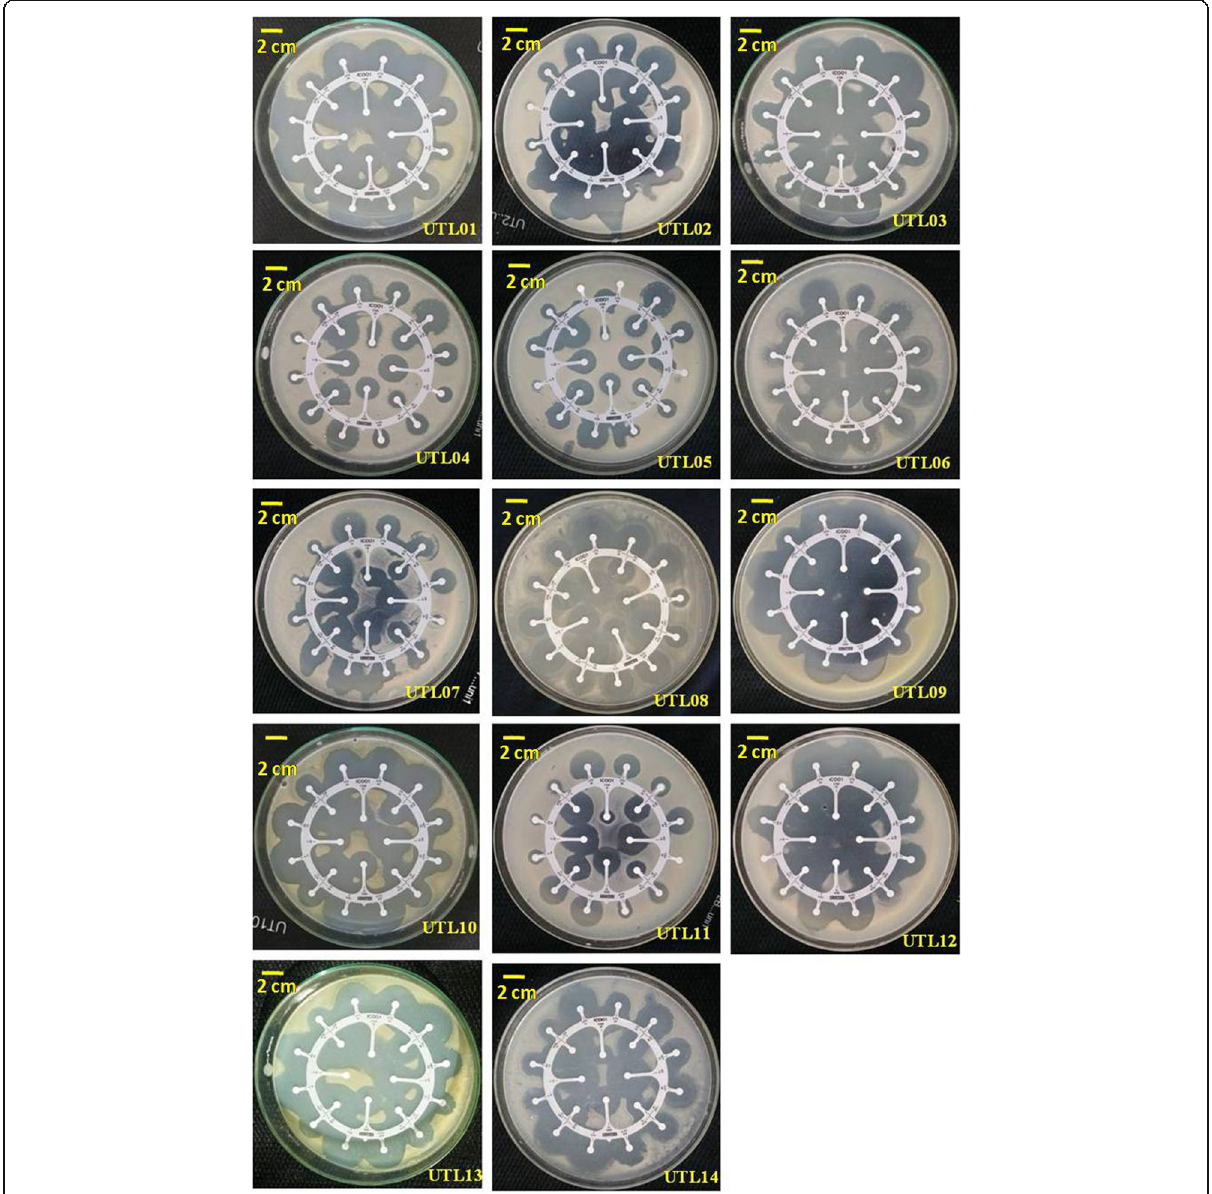
Fig. 1 Antimicrobial assay of bacteria from untreated